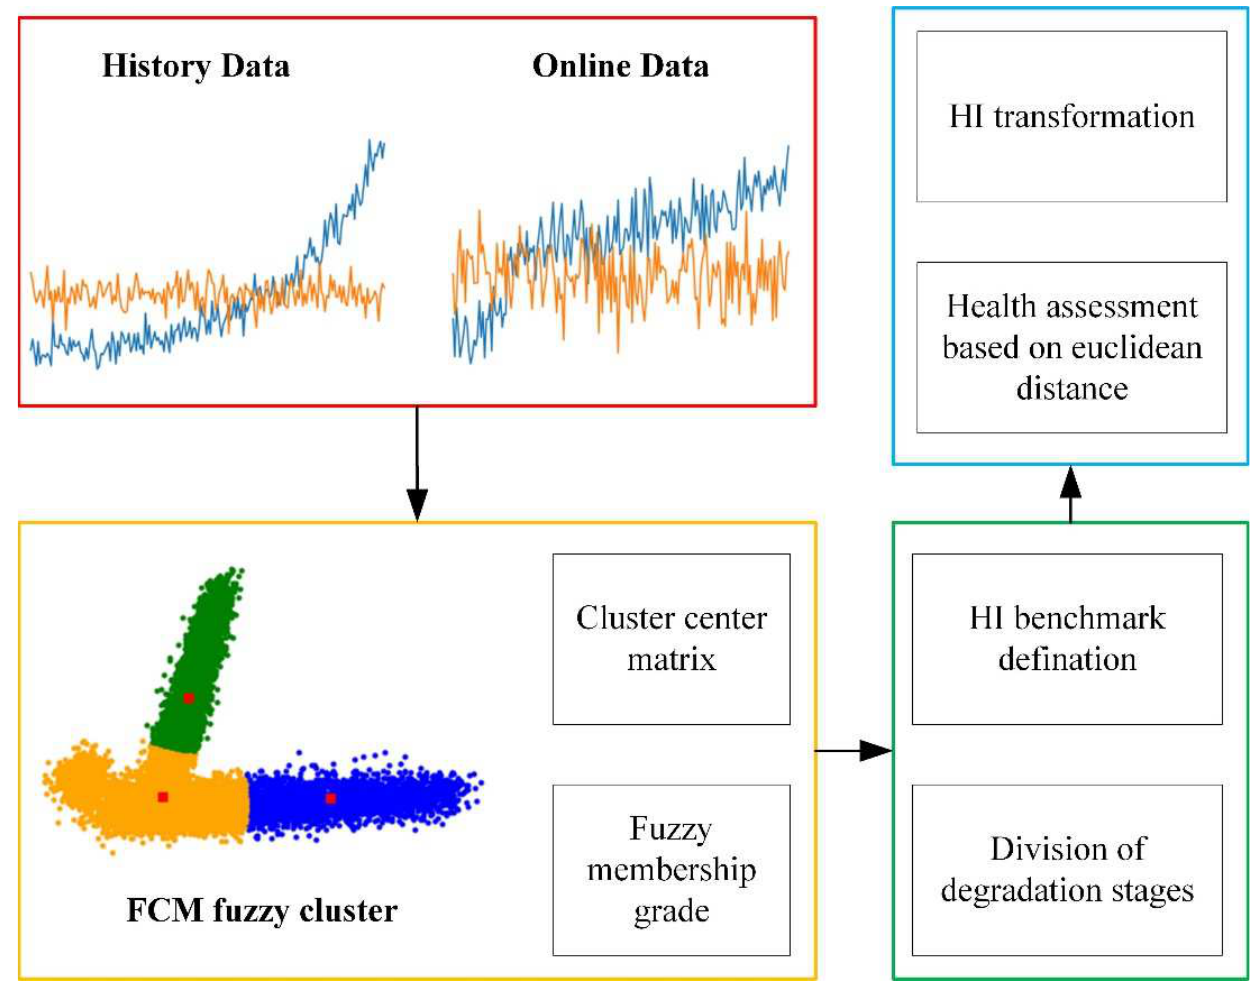
Figure 4. HI construction based on fuzzy clustering.